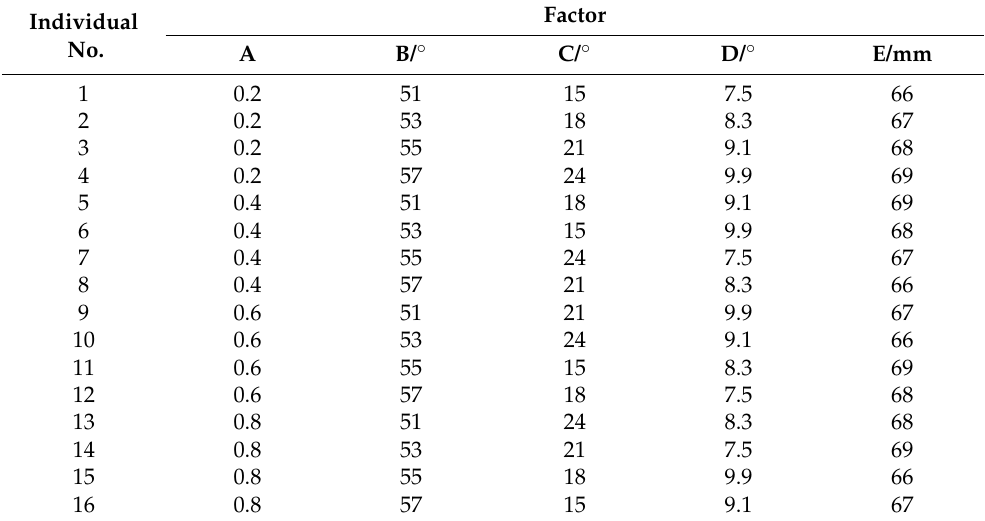
Table 3. Orthogonal